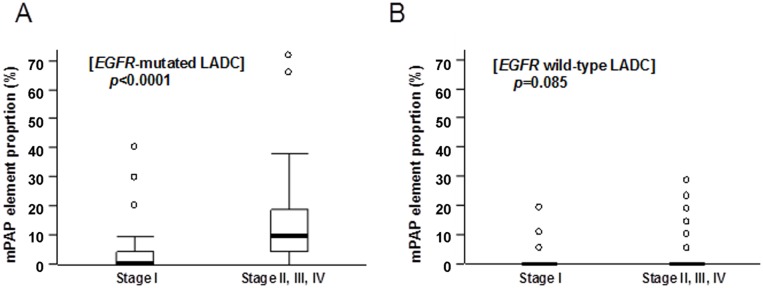
Proportions of the micropapillary (mPAP) element in different stages of surgically resected lung adenocarcinomas (LADCs).A, stage I EGFR-mutated LADCs (n = 103) versus (vs) stage II-IV EGFR-mutated LADCs (n = 39); B, stage I EGFR wild-type LADCs (n = 106) vs stage II-IV EGFR wild-type LADCs (n = 88); n, number of tumors examined mPAP element proportions are displayed as a box-and-whiskers plot with median (thick line), 25th to 75th percentile (box) and 10th to 90th percentile (whiskers) and outliers (circles). P-values were calculated using the Mann-Whitney test.